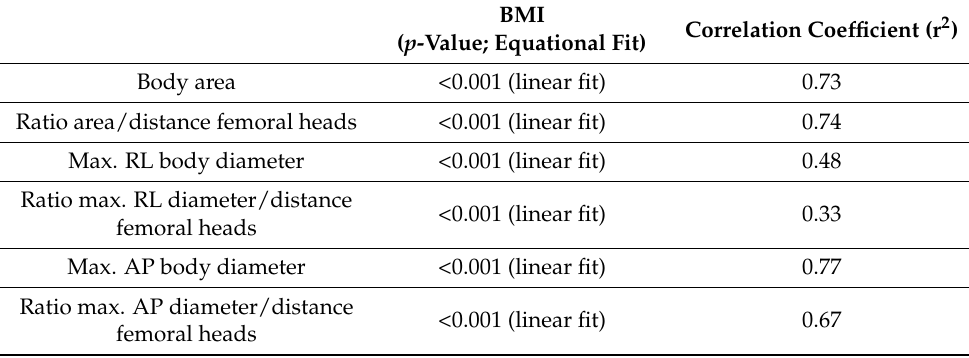
Table 2. Correlation of the measured body contour parameters in CT at the femoral head level with the body mass